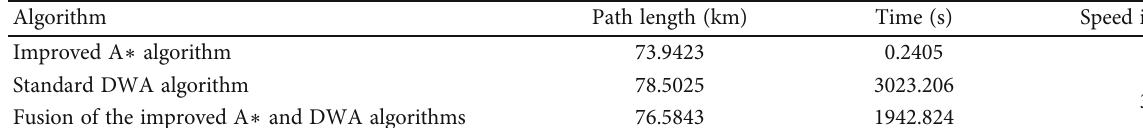
Table 2: Path planning results when the obstacles are unknown.